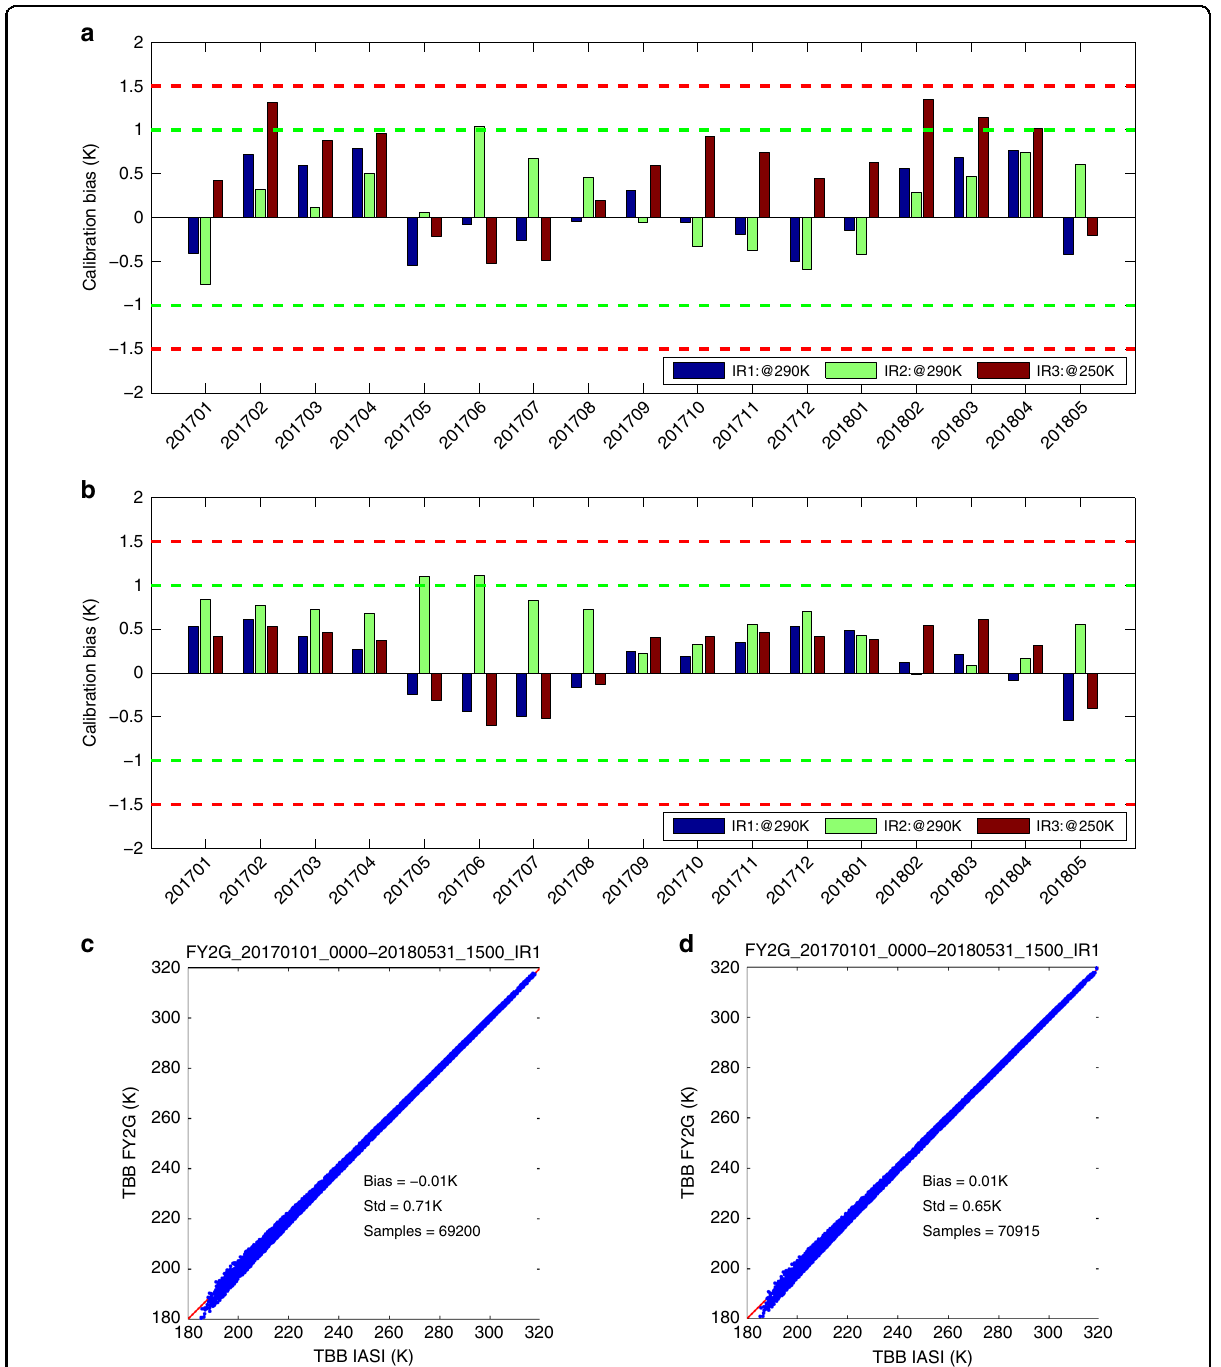
Fig. 2 Comparison of calibration biases of FY-2G VISSR from both IBBC and SIRC methods for the period between January 2017 and May 2018. a Monthly biases of FY-2G VISSR IR1 – IR3 bands with IBBC method; b Monthly biases of FY-2G VISSR IR1 – IR3 bands with SIRC method; c Scatter plots of the collocated observations between FY-2G IR1 band and IASI with IBBC method; d Scatter plots of the collocated observations between FY- 2G IR1 band and IASI with SIRC